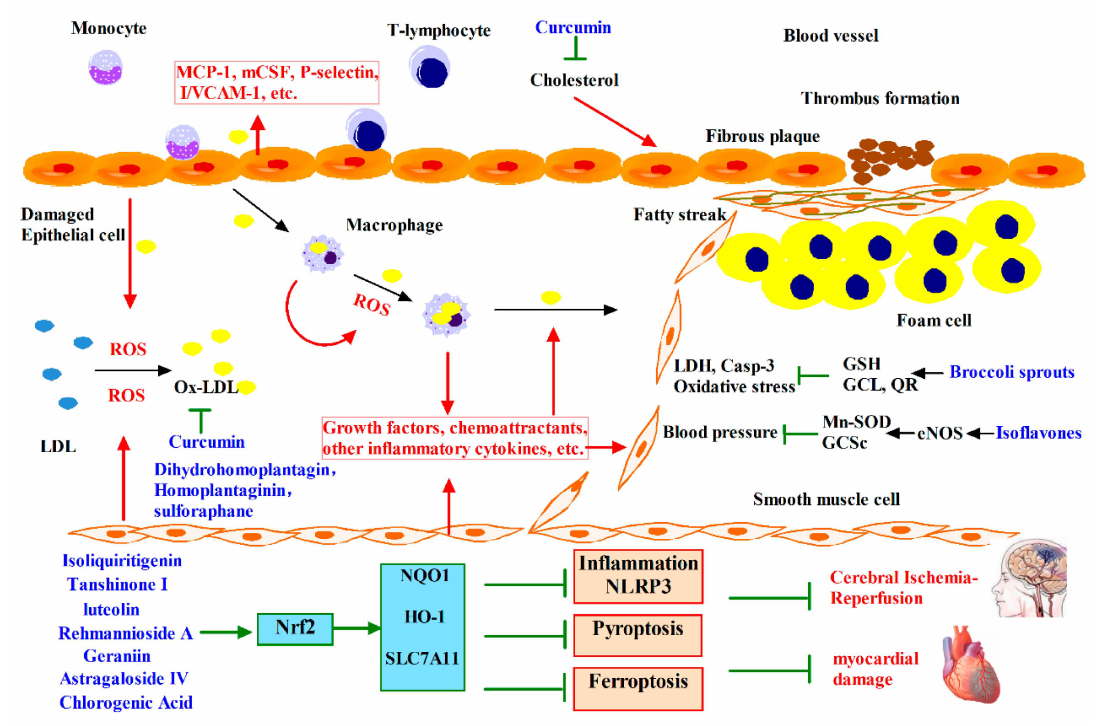
Figure 3. Phytochemicals target Nrf2 for cardiovascular diseases intervention. Ox-LDL can damage endothelial cells and induce the expression of proinflammatory cytokines. Monocytes take up lipopro- teins and metamorphoze into macrophages, which can produce reactive ROS, and subsequently convert Ox-LDL to highly oxidized LDL and form foam cells, combine with leukocytes to form fatty streaks and eventually form fibrous plaques that protrude into the arterial lumen, leading to vascular obstruction. A variety of phytochemicals are found to activate the Nrf2 signaling pathway to ameliorate oxidative stress and prevent fibrous plaque formation. Phytochemicals attenuate heart and brain damage after ischemia-reperfusion injury by inhibiting inflammation, apoptosis and